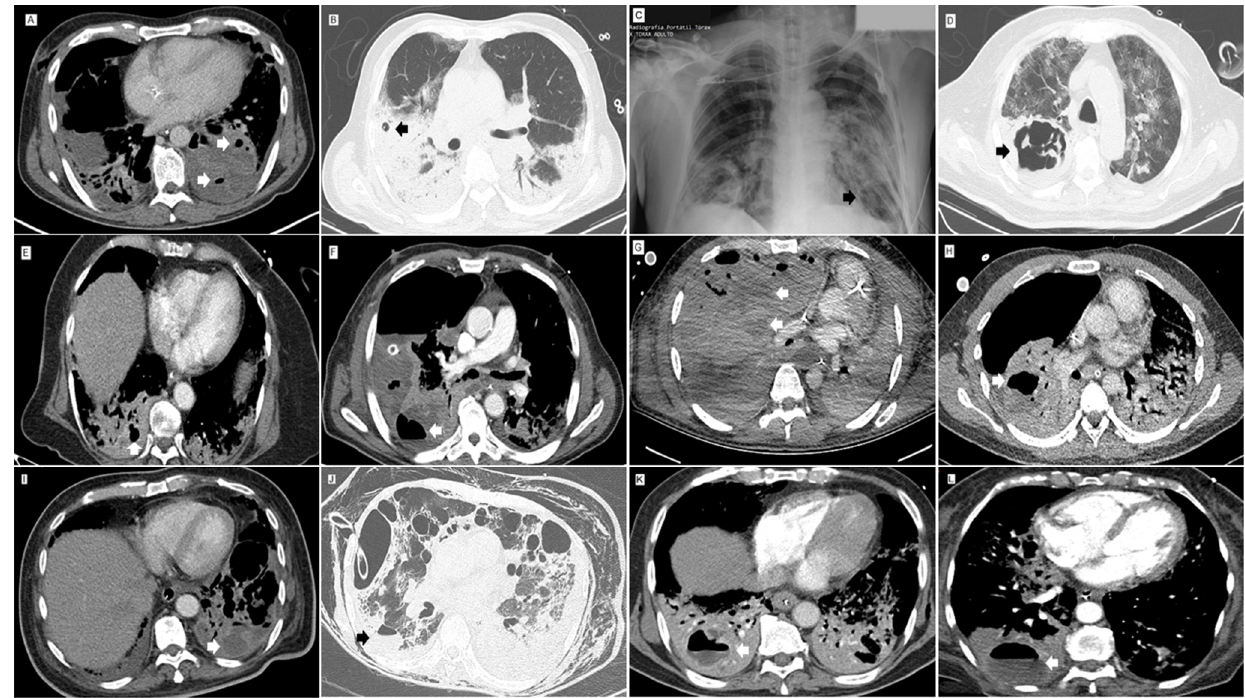
Figure 1. Lung images of post-COVID-19 necrotizing pneumonia. ( A ) Contrast CT. Mediastinal Window. Low density area of the left lower lobe lung parenchyma with loss of parenchymal enhancement, with architectural distortion and small abnormal gas-filled spaces (arrows) due to necrotizing pneumonia. ( B ) Non-contrast CT. Lung Window. Small round 9 mm thin-walled, air-filled lesion (pneumatocele) (arrow) in a right upper lobe area of consolidation. ( C ) Chest X-Ray. Well-defined 20 mm thin-walled area of parenchymal lucency (arrow) within area of consolidation in the left lower lobe. Pneumothorax. ( D ) Non-contrast CT. Lung Window. Thick-walled and irregular cavity (arrow) with septum due to lung abscess within area of necrotizing pneumonia. ( E ) Contrast CT. Mediastinal Window. Heterogeneous attenuation of the right lower lobe lung parenchyma with a consolidation pattern with low-density areas, loss of parenchymal enhancement and small air-filled rounded lesions (arrow) due to necrotizing pneumonia. ( F ) Contrast CT. Mediastinal Window. Large low-density area with loss of parenchymal enhancement of the right upper lobe lung parenchyma associated with thin-walled air-fluid level cavity due to necrotizing pneumonia with lung abscess. Large air-fluid level (arrow) in the pleural space due to empyema. ( G ) Contrast CT. Mediastinal Window. Large area with increase in parenchymal attenuation with a consolidation pattern and low-density areas (arrows), loss of parenchymal enhancement, architectural distortion, and peripheral air-filled rounded lesions due to necrotizing pneumonia. ( H ) Contrast CT. Mediastinal Window. Low-density area with loss of parenchymal enhancement in the right lower lobe, associated with adjacent cavitary lesion (arrow) due to necrotizing pneumonia and lung abscess. ( I ) Contrast CT. Mediastinal Window. Area of consolidation in the left lower lobe with low-density areas (arrow) of liquid content with subtle peripheral enhancement due to necrotizing pneumonia with abscess. ( J ) Non-contrast CT. Lung Window. A 3-cm thin-walled collection with air-fluid level (arrow) due to superinfection of a lung cavity or abscess in the right lower lobe. ( K ) CT pulmonary angiography. Mediastinal window. Bilateral lower lobe consolidation and collection with air-fluid level (arrow) with peripheral enhancement in right lower lobe due to lung abscess. ( L ) CT pulmonary angiography. Mediastinal window. Collection with air-fluid level (arrow) with low peripheral enhancement in right lower lobe consolidation due to lung abscess.